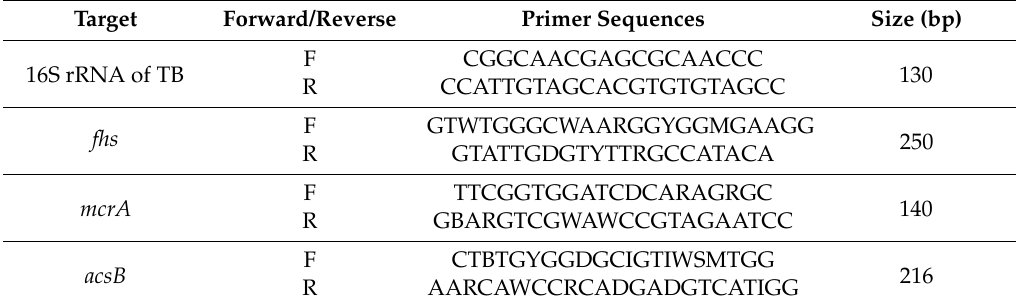
Table 2. Primers used in this